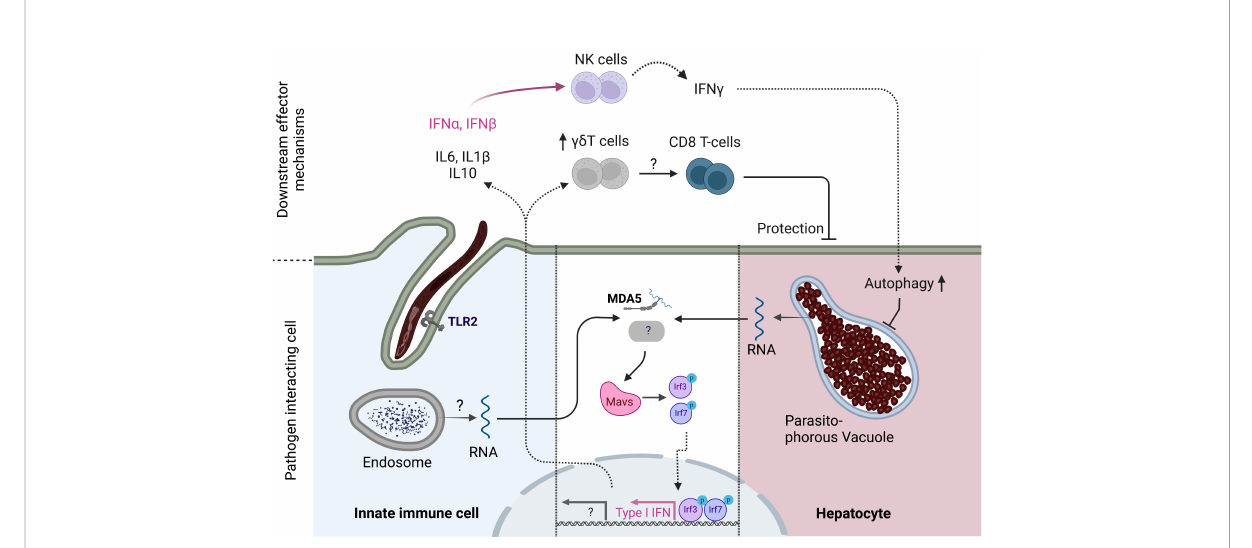
FIGURE 1 Innate immune response to pre-erythrocytic stages of Plasmodium parasites. Cytoplasmic Plasmodium RNA is sensed by MDA5 which signals via MAVS. MAVS activation ultimately leads to the phosphorylation of transcription factors IRF3 and IRF7 which drive the expression of Type I IFN genes such as IFN a and IFN b . IFN a , b recruit NK cells to the liver which produce IFN g which in turn increases autophagy pathways in hepatocytes. Another, yet unidenti fi ed, PRR might signal via MAVS to enhance this response. The cell type of origin of the initial Type I IFN response has not been identi fi ed and could either be infected hepatocytes or tissue resident innate cells that have taken up parasite material. TLR2 has been shown to be capable of sensing sporozoites, leading to reduced liver stage burden and enhanced in fl ammatory gene expression in mice. In addition, gd T-cells have been linked to favorable vaccination outcomes in humans and play a role in inducing a protective CD8 T-cell response in concert with CD8 + cDC1s in mice. Created with